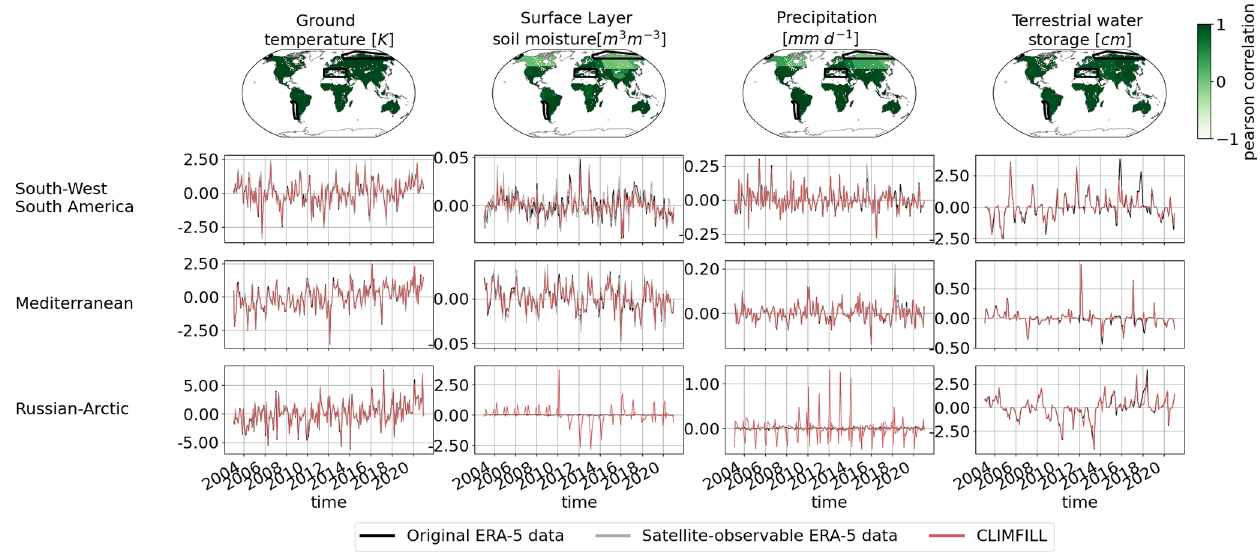
Figure 12. Pearson correlation of regionally averaged, deseasonalized monthly averages between CLIMFILL and the original ERA-5 data over IPCC reference regions (AR6 regions, Iturbide et al., 2020) (top row). Regionally averaged monthly averages of the physical values over selected regions in original ERA-5 data, satellite-observed ERA-5 data, and gap-filled CLIMFILL data (bottom three rows). The selected regions show the advantages and problems of each framework. For more information, see Sect. 4.3. For all other AR6 regions, see Fig. A5 in Appendix